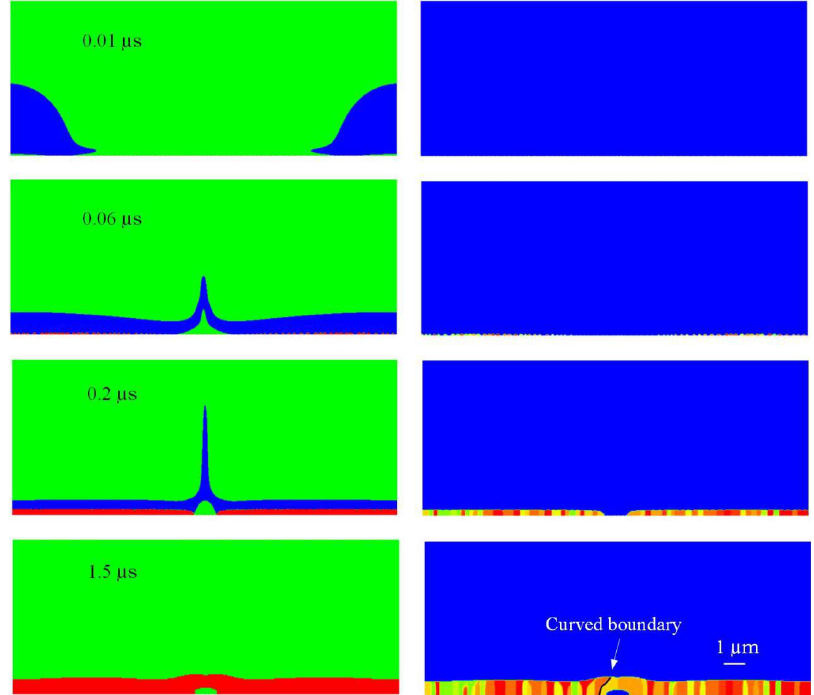
Figure 10. Typical binary droplet impact under plasma spraying conditions. In the left column, red denotes solid, green gas, and blue liquid. In the right column, blue signifies fluid while the others represent crystals of distinct orientations.